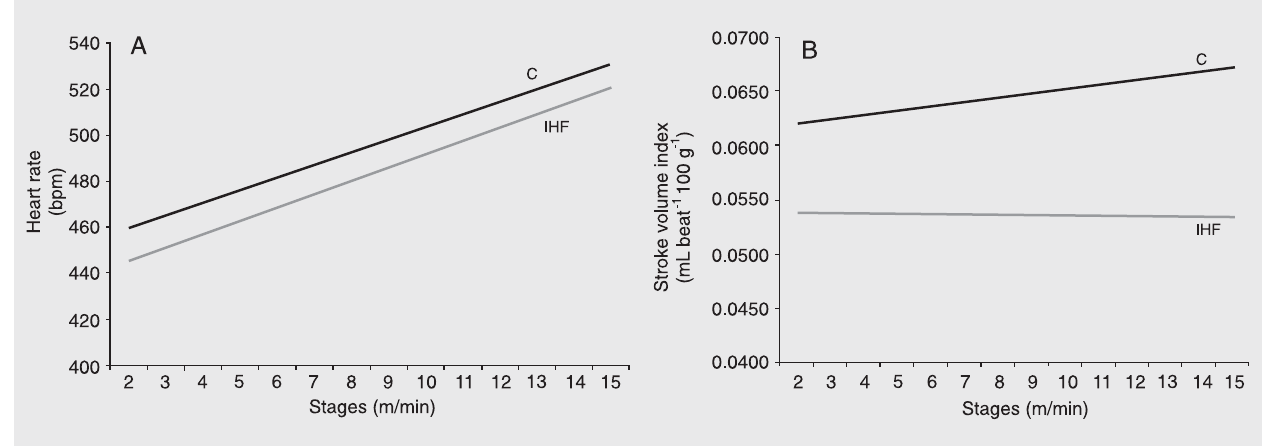
Figure 3. Time course of heart rate (HR, panel A) and stroke volume index (panel B) during progressive exercise in normal control (C) and ischemic heart failure (IHF) rats. Note that the HR responses of both groups were similar but, in contrast, stroke volume index responses were reduced in ischemic heart failure rats compared to normal controls. Panel A: C (y = 5.4922x + 454.05, r 2 = 0.955), IHF (y = 5.767x + 439.67, r 2 = 0.932). Panel B: C (y = 0.0004x + 0.0616, r 2 = 0.797), IHF (y = -0.00003x + 0.0538, r 2 = 0.117) (P ≤ 0.05, unpaired Student t